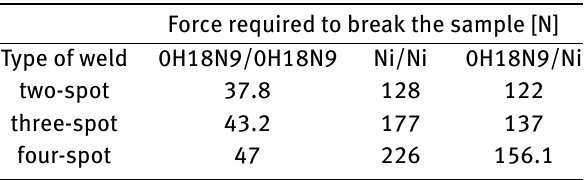
Table 1: Summary of the forces needed to break the prepared sam-